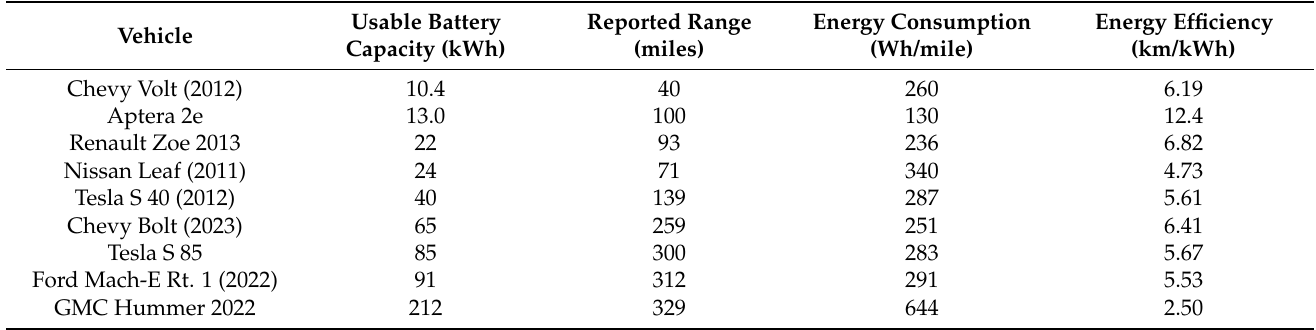
Table 2. Reported battery capacity, range, calculated energy consumption (Wh/mile), and energy efficiency (km/kWh) for diverse EVs, including older and newer models. Ranked by battery capacity in